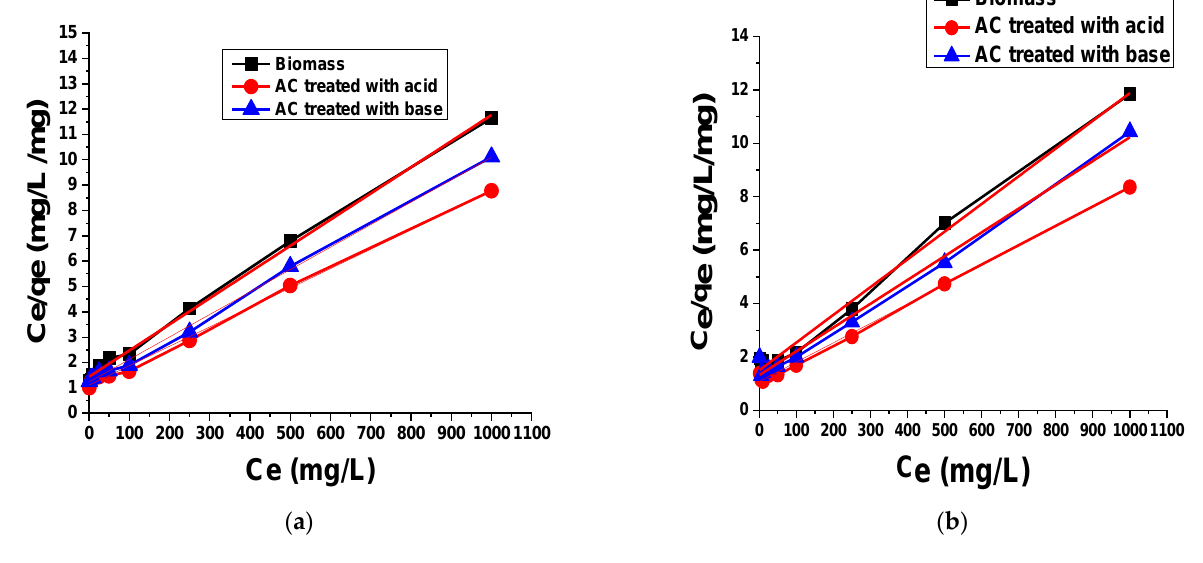
Figure 6. Langmuir adsorption isotherm of ( a ) TB and ( b ) XO on biomass and AC treated with acid and base. The R 2 values for the adsorption of XO on biomass, AC treated with acid and AC treated with base are 0.992, 0.997, 0.990, respectively. These values were also close to the unity. The highest adsorption capacities for the adsorption of XO on biomass, AC treated with acid and AC treated with base were 96.43 mg/g, 138.12 mg/g, and 112.36 mg/g, re- spectively. The K L values obtained from the plot were 0.0096 dm 3 /mg, 0.0067 dm 3 /mg, and 0.0067 dm 3 /mg, for biomass, AC treated with acid and AC treated with a base, respec- tively.